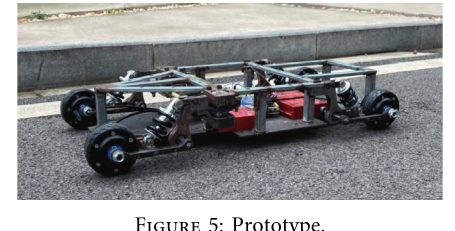
Figure 5: Prototype.